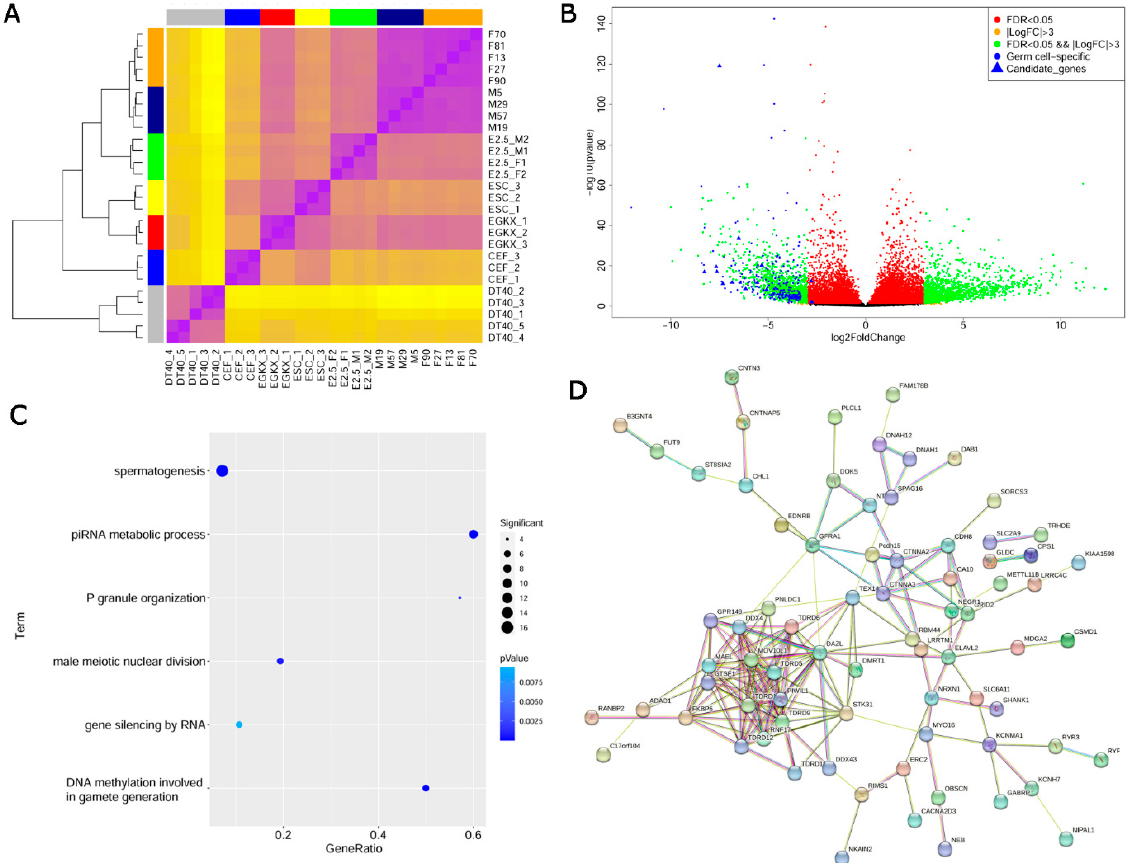
and signal transduction (FDR: 1.08 × 10 − 2 ) (Figure S3A).